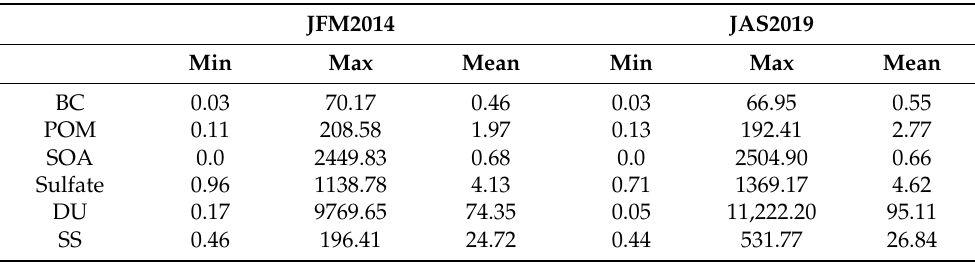
Table 2. Global mean total column mass concentrations (in mg/m 2 ) of MAM4 species (BC, POM, SOA, sulfate, DU, and SS) summed over modes for JFM2014 and JAS2019 in BAM AMIC